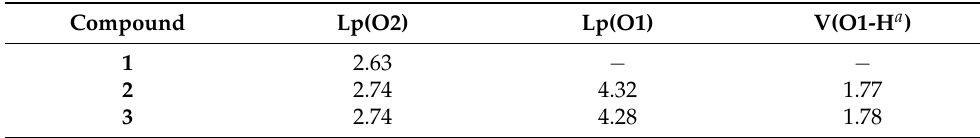
Table 3. Electron populations of selected basins of the Electron Localization Function related to the intramolecular hydrogen